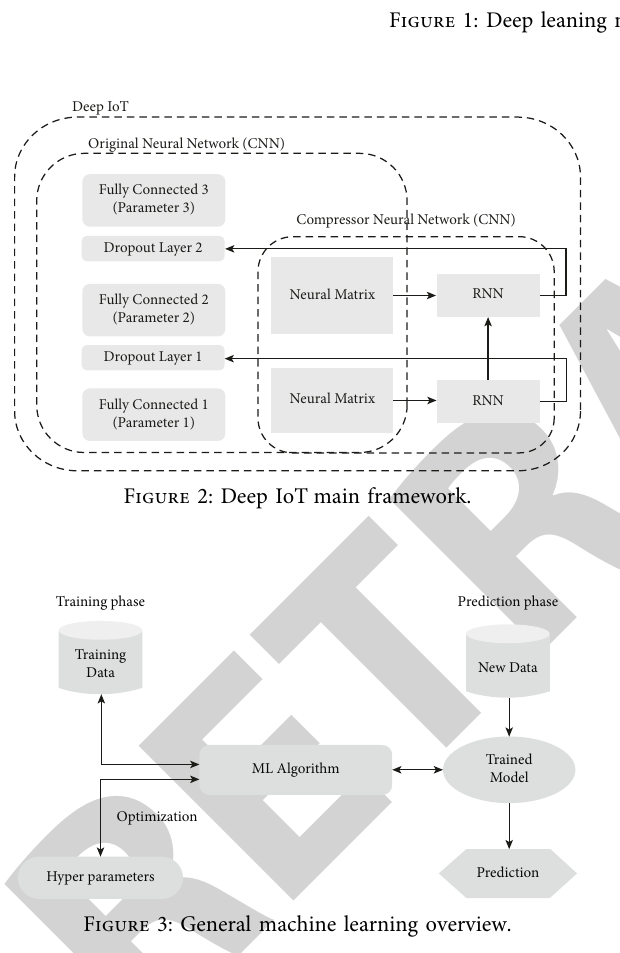
Figure 1: Deep leaning neural network approach.